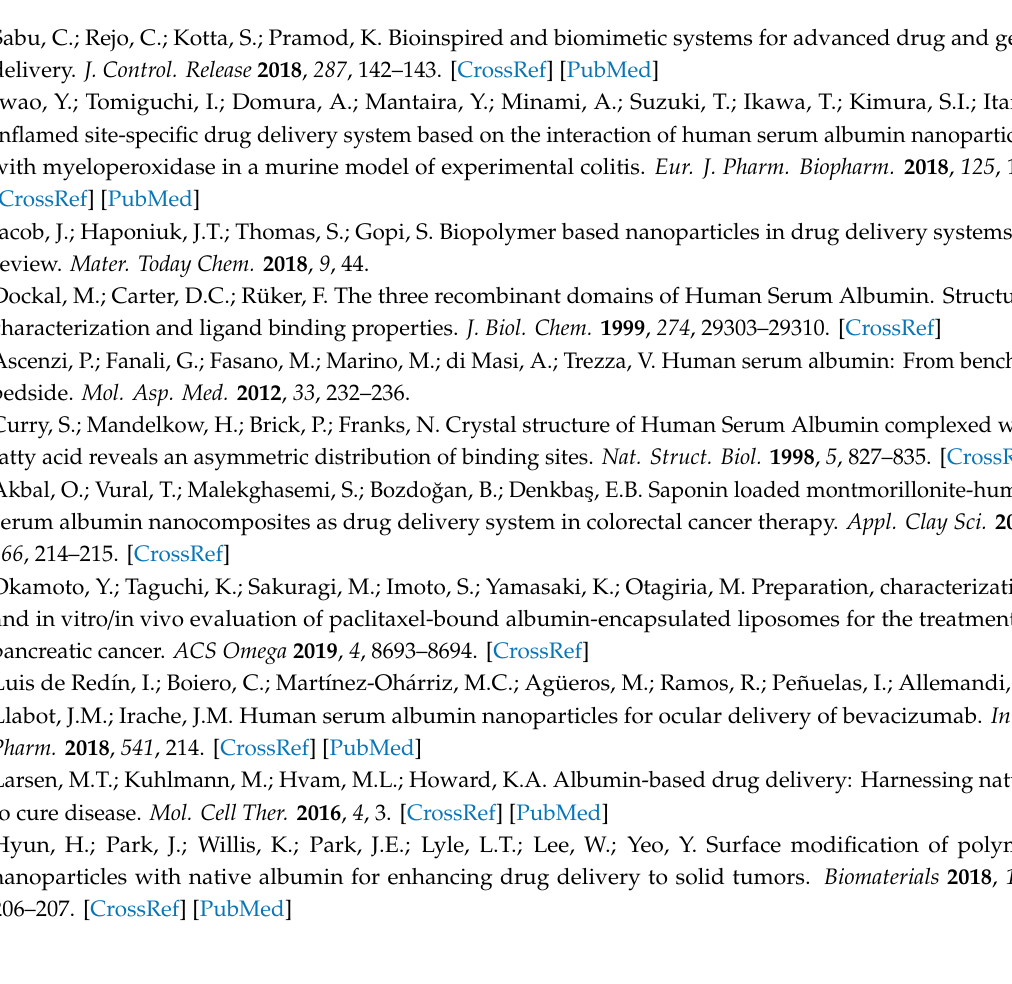
Figure S1: UV-Vis spectra recorded on the first, second, and third days of incubation of HSA-LYQLENY complex in the presence of Congo Red, Figure S2: UV-Vis spectra recorded on the first, second, and third days of incubation of HSA-VEALYL complex in the presence of Congo Red, Figure S3: The intensity of fluorescence spectra recorded on the first, second, and third days of incubation of HSA-LYQLENY complex in the presence of Thioflavin T, Figure S4: The intensity of fluorescence spectra recorded on the first, second, and third days of incubation of HSA-VEALYL complex in the presence of Thioflavin T, Figure S5: Fluorescence spectra of PBA in the function of HSA centration. [PBA] = 15 µ M, λ exc = 337 nm. Insert: Intensity of fluorescence recorded at 376 nm as a HSA concentration, Figure S6: Time profiles of PBA [15 µ M] fluorescence decay in bu ff er and in the presence of HSA; Figure S7: Panel I: Normalized absorption spectra of Py-LYQLENY (a) and Py-VEALYL (b) in di ff erent solvents. Panel II: Normalized emission spectra of Py-LYQLENY (a) and Py-VEALYL (b) in di ff erent solvents, λ exc = 342 nm, Figure S8: Fluorescence spectra of Py-LYQLENY in PBS solutions recorded for the given probe concentration (a), normalized spectra for minimum and maximum concentrations (b), λ exc = 337 nm, Figure S9: Dependence of fluorescence intensity of Py-LYQLENY (2), registered at λ = 376 nm, as a function of concentration, λ exc = 337 nm, Figure S10: Transient absorption spectrum of pulse irradiated (17 ns, dose 55 Gy) aqueous solution of Py-LYQLENY (20 µ M) containing 0.2 M t-BuOH. Nitrogen saturated, Table S1: Best fit parameters and average lifetimes < τ > for PBA fluorescence decays recorded in bu ff er with and without